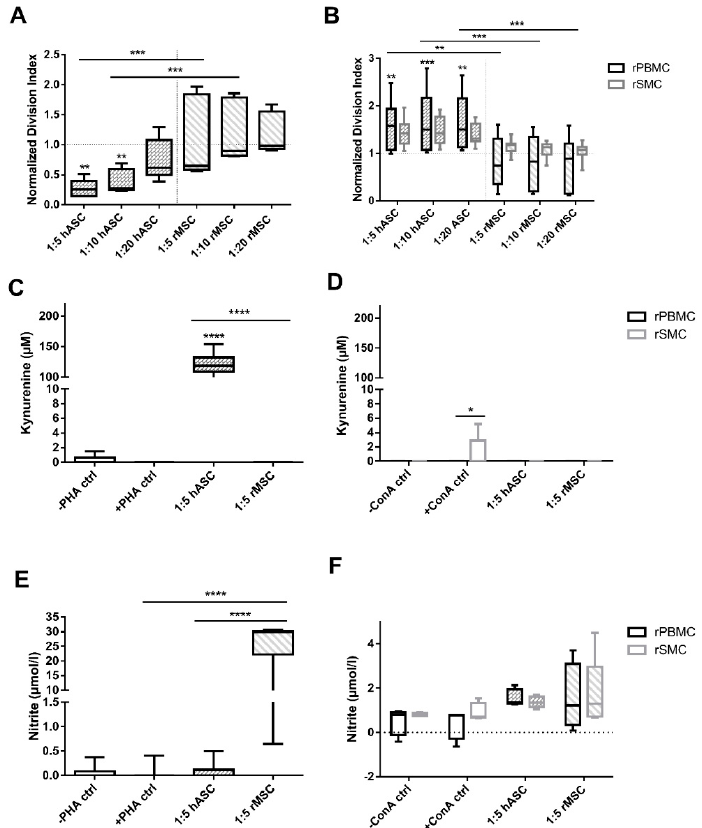
Figure 6. ASC are able to inhibit hPBMC proliferation, but not rPBMC, however, rMSC slightly suppress hPBMC and inhibit blood-derived rPBMC to a higher extent than rSMC. ( A ) Cocultures with hPBMC and hMSC (ASC) and rMSC. ASC inhibited hPBMC in a dose dependent manner, n = 5. ( B ) rPBMC and rSMC cocultures with hMSC and rMS, n = 8 to 10. ( C ) Kynurenine concentrations in hPBMC:ASC or rMSC coculture supernatants, n = 3 to 10. ( D ) Kynurenine concentrations in rPBMC or rSMC:ASC or rMSC coculture supernatants, n = 5 ( E ) Nitrite concentration measured in cocultures with hPBMC, n = 3 to 10. ( F ) Nitrite concentrations in rPBMC or rSMC:ASC or rMSC coculture supernatants, n = 4 to 6. Box: interquartile range; whiskers: minimum to maximum; line: median. Dotted lines represent the normalisation referred to the positive control. Asterisks depicted at the top of the bars represent the significance of the individual value with respect to their own control. Lines with asterisks depict the significance between two conditions. (* p < 0.05, ** p < 0.01; *** p < 0.005, **** p <